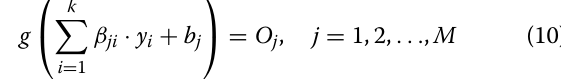
decoded in the final stage into the correct bit sequence, as shown in Fig. 5.